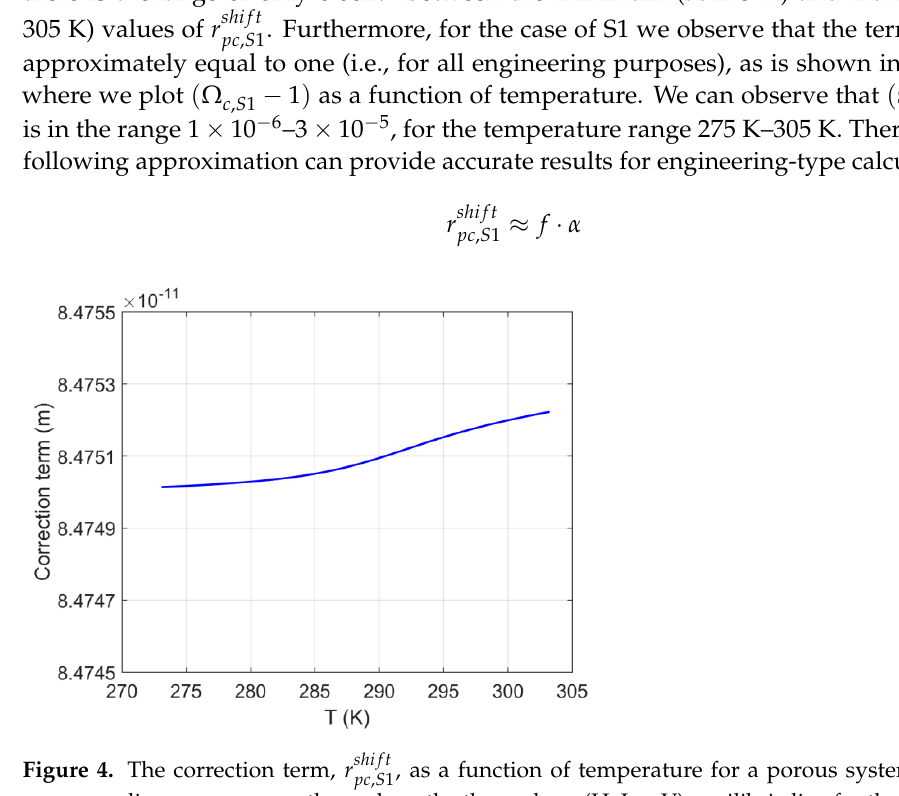
Figure 5. Plotting the term )( ,